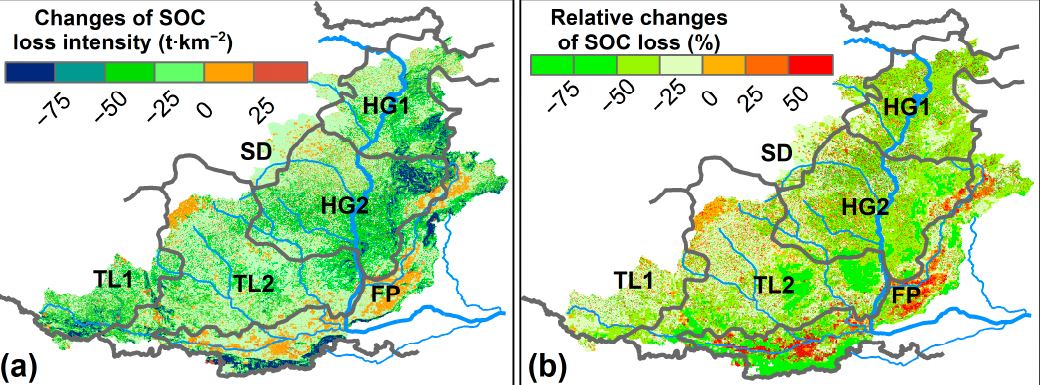
Figure 6. Change in SOC loss in the Hetong region: ( a ) change magnitude and ( b ) relative changes.